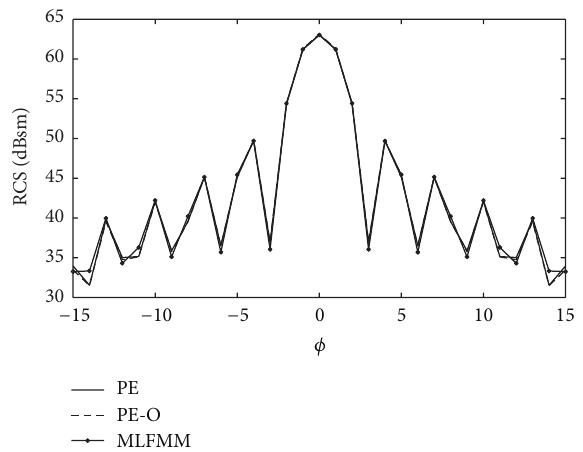
Figure 1: RCS of a PEC cuboid calculated by PEs and MLFMA.